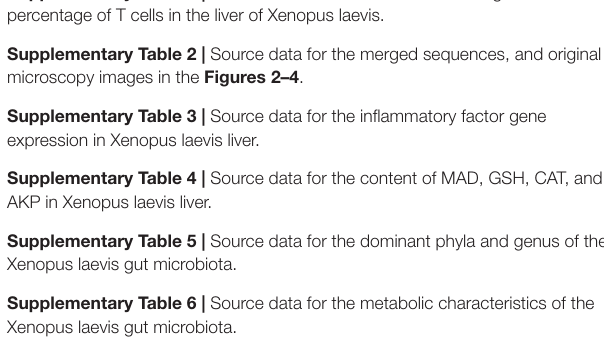
Supplementary Table 1 | Source data for the intestinal villus height and percentage of T cells in the liver of Xenopus laevis. Supplementary Table 2 | Source data for the merged sequences, and original microscopy images in the Figures 2–4 . Supplementary Table 3 | Source data for the inflammatory factor gene expression in Xenopus laevis